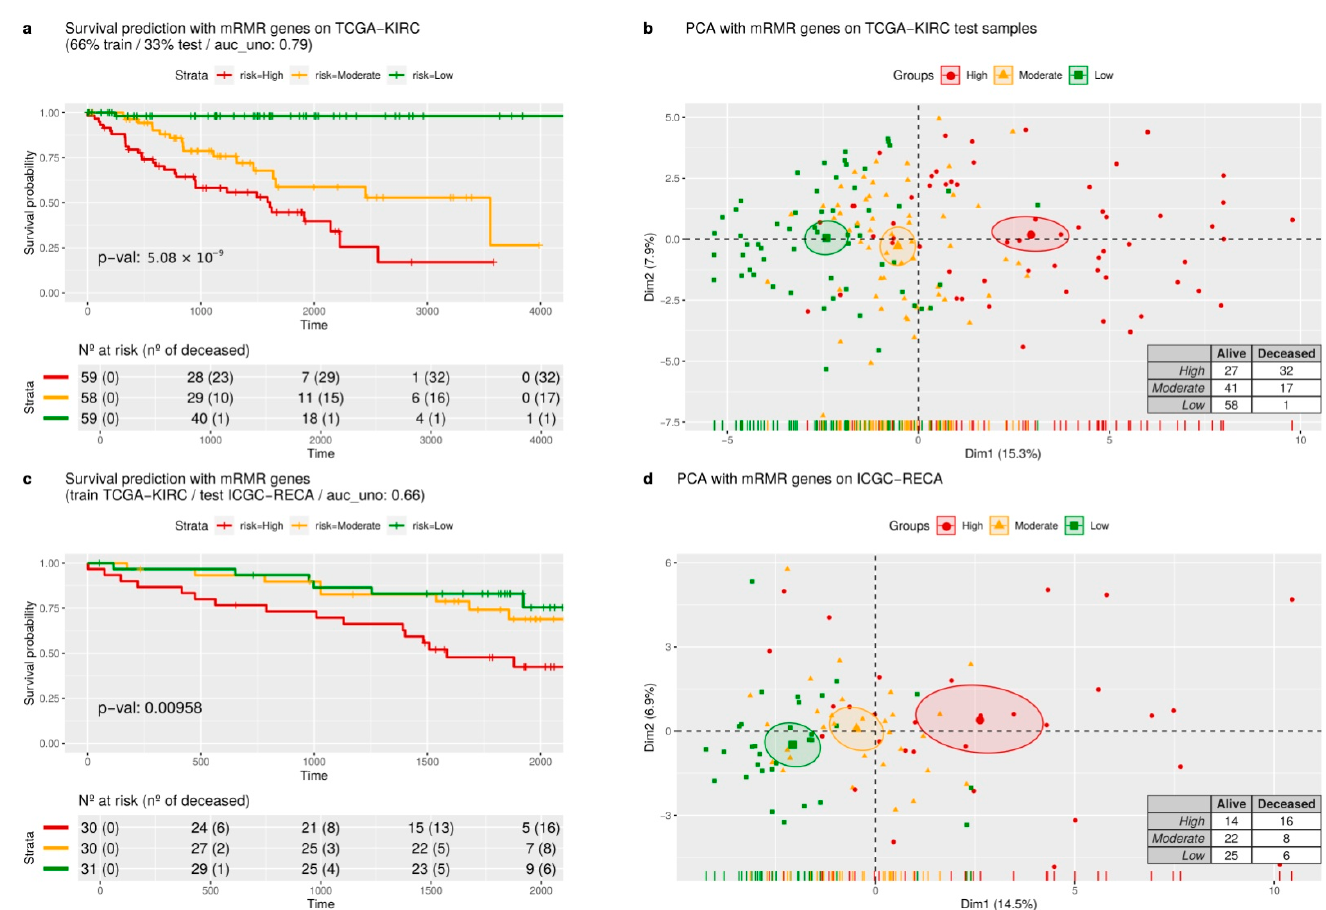
Figure 4. Survival risk predictions with mRMR signature and dimensionality reduction. ( a ) The survival curves are predicted in three equal-size strata of risk groups of the TCGA-KIRC dataset: higher risk (red), lower risk (green), and moderate risk (orange). ( b ) A dimension reduction of genes from the mRMR signature, using principal components analysis. ( c ) The survival curves were predicted by validating the ICGC-RECA dataset. ( d ) The principal components analysis of the ICGC-RECA dataset with genes of mRMR signature.